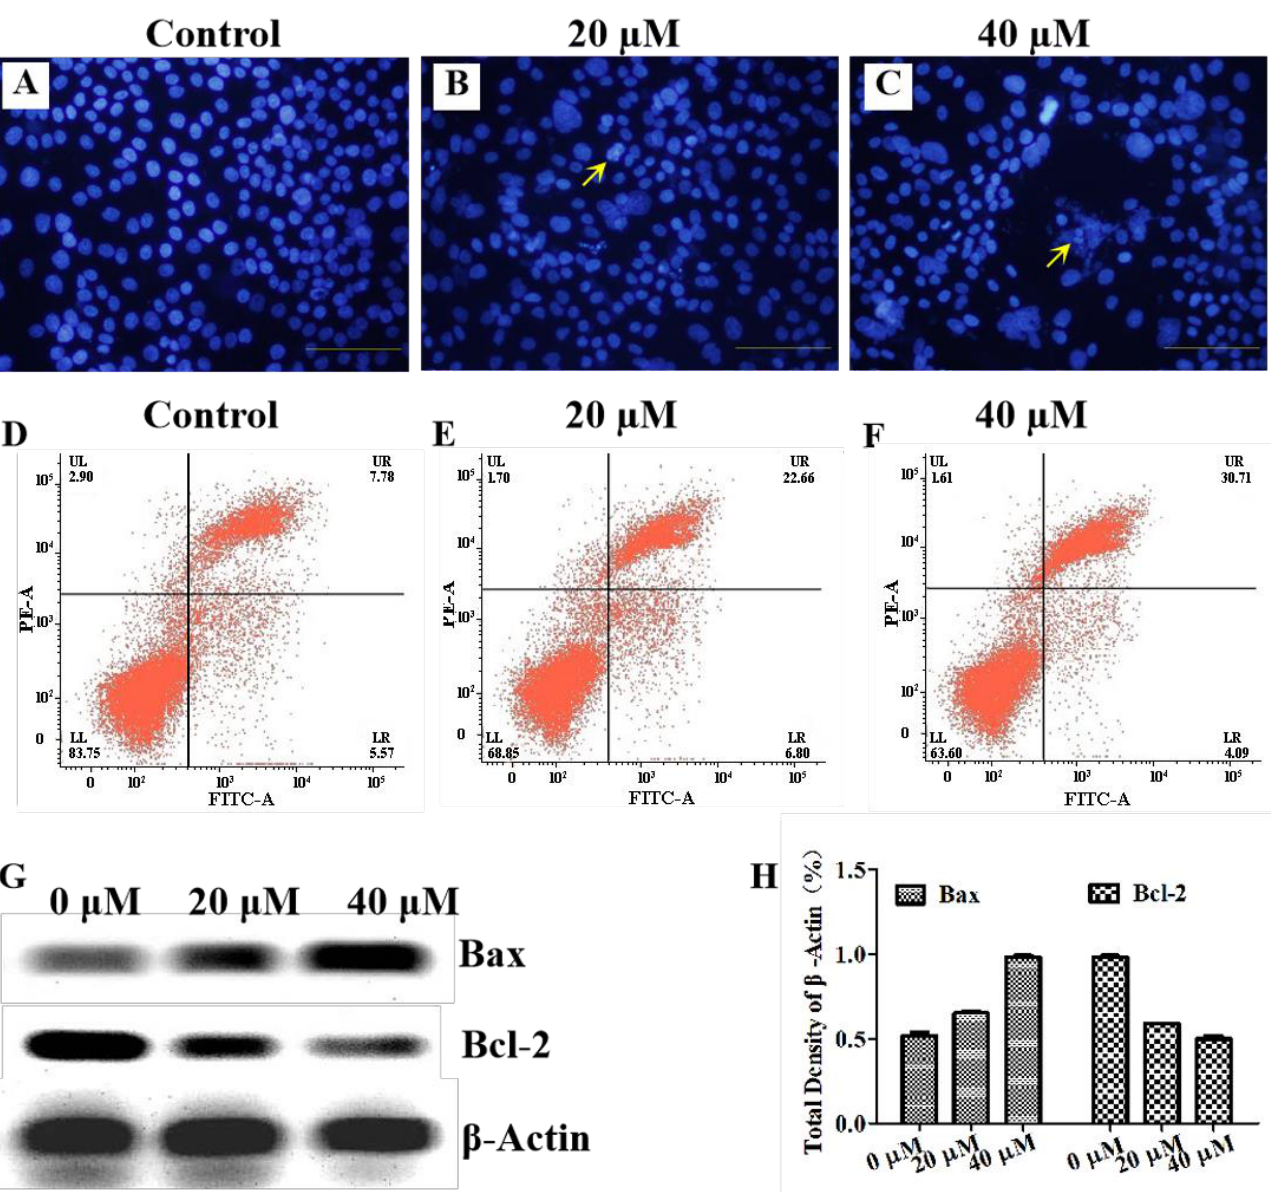
Figure 2. G-6 induced SW1990 cells apoptosis. ( A – C ): Representative images of SW1990 cells treated with DMSO or G-6 (20 µ M and 40 µ M) in cell morphology assay for 24 h. ( D – F ): Representative images for SW1990 cells treated with DMSO or G-6 (20 µ M and 40 µ M) for 24 h prior to staining with Annexin V-FITC/PI staining followed by flow cytometry analysis. ( G , H ): Representative Western blotting assay images are shown for SW1990 cells treated with DMSO or G-6 (20 µ M and 40 µ M) for 24 h and immunoblotting with anti-Bax, and anti-Bcl-2. Data shown are means ± SEM ( n =